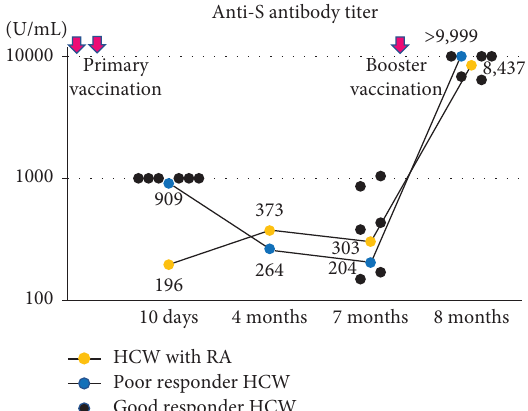
Figure 1: Anti-S antibody titer after primary vaccination and before and after booster vaccination. Anti-S antibody titer levels are shown for the RA patient taking MTX (yellow circle), poor re- sponder HCW (blue circle), and good responder HCW (black circle). Te time course of the titers of the RA patient and poor HCW are illustrated by solid lines. Te measured values of good responder HCWs are presented in Supplementary Table S1. Overlapping circles are displayed as horizontal shifts. Anti-S an- tibody: antispike antibody, RA: rheumatoid arthritis. HCW: healthcare worker, MTX: methotrexate.